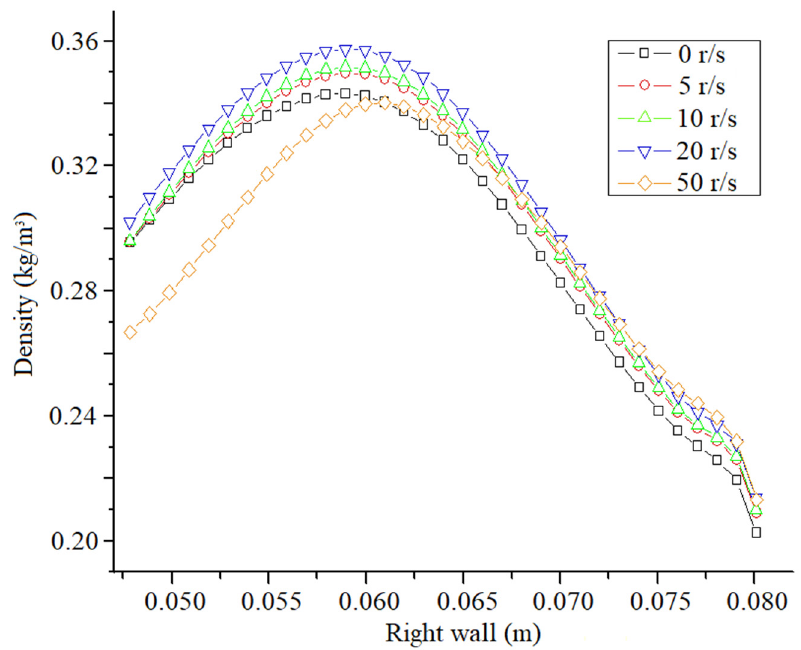
Figure 16. Density distribution of the right wall of the supersonic fluidic element at different rotational angular velocities.